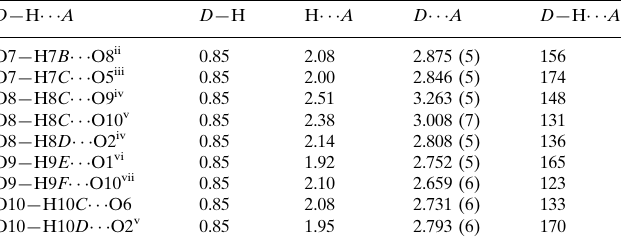
Hydrogen-bond geometry (A˚ , (cid:2)